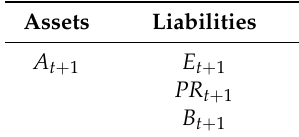
Table 2. Balance sheet of the life insurer at time t +